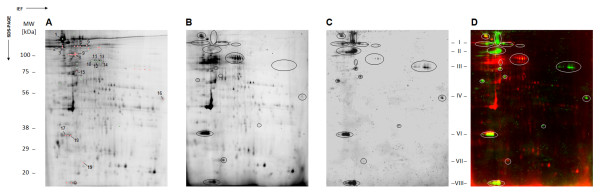
Determination of protein spots detected by BEI sera on iRBC membrane protein extracts by 2-D immunoblotting. A 2-D immunoblot using a fluorescence-based method was performed to detect precisely and accurately antigenic protein spots. (A) Protein profile of iRBC membrane protein extracts pre-labelled with Cy5 and separated by 2-D electrophoresis. (B) Protein profile of the same protein sample used in "A" after Cy5 labelling, separation by 2-D electrophoresis and electroblotting onto nitrocellulose membrane. (C) Immunoblot pattern of a pool of 5 selected BEI sera revealed with a goat-anti-human IgG FITC-conjugate against iRBC membrane protein extracts. (D) Merged images of the electrobloted protein profile (e.i., "B") and the immunoblot pattern (e.i., "C"). Antigenic spots detected onto immunoblot (e.i., "C") are ringed and reported onto electrobloted protein profile (e.i., "B") and merged images (e.i., "D"). Antigenic spots which were excized for mass spectrometry (MS) analysis are marked with red or green circles onto gel image and those which were identified are indicated by Arabic numbers (e.i., "A"). Selected antigenic bands are indicated by Roman numbers and positioned according to their MW. Antigenic spots corresponding to selected antigenic bands are indicated by red circles, the others antigenic spots are assigned by green circles (A). A resume of the correspondence between Roman and Arabic numbers is indicated in additional file 2. MW: molecular weight, kDa: kiloDalton.